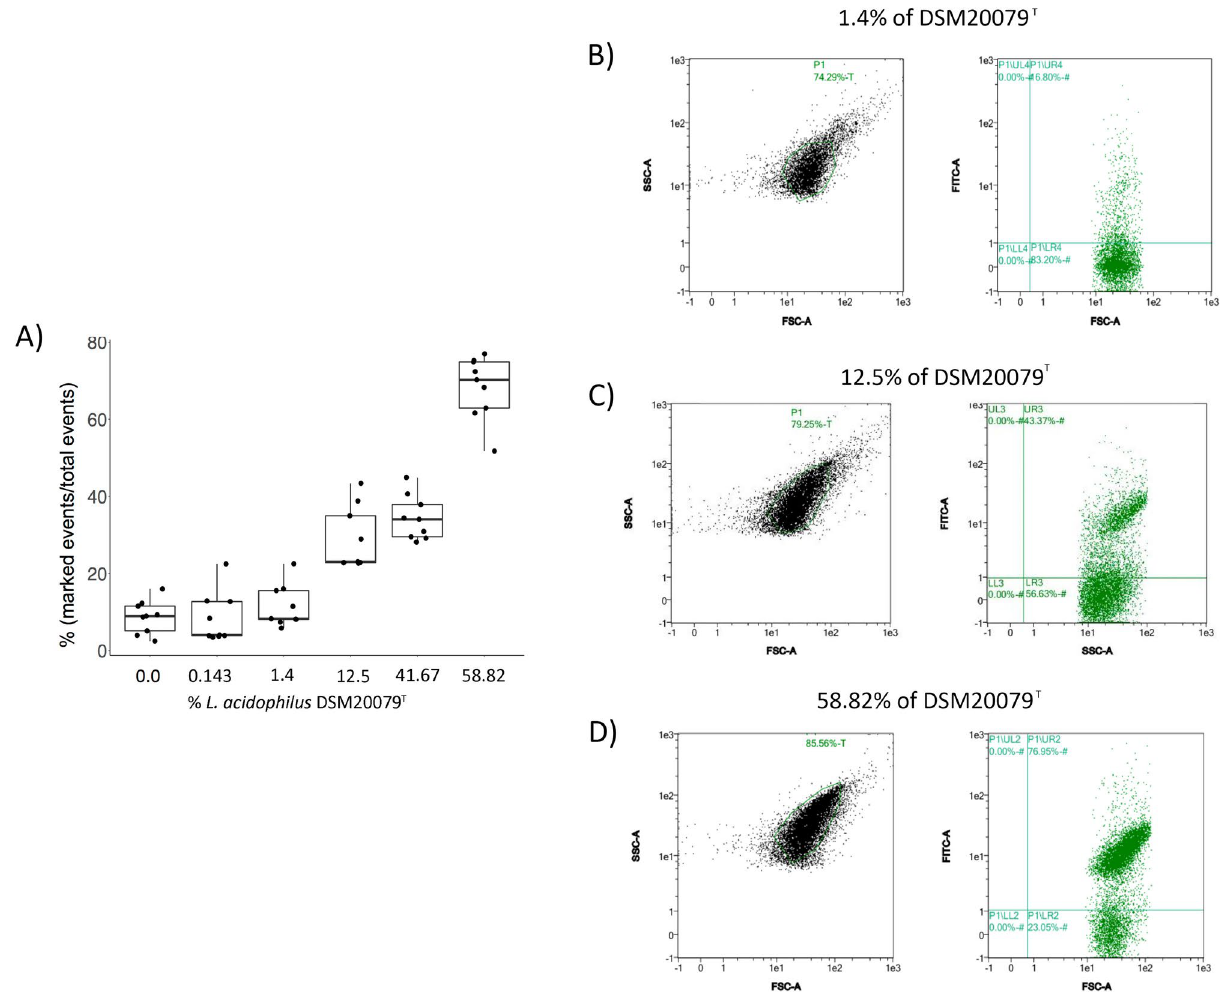
Figure 3. (A) Boxplot/jitter diagrams showing the percentage of L. acidophilus DSM20079 T cells labelled in a defined bacteria consortium representing a synthetic human gut microbiota. Data are represented as the mean ± SD of at least three independent experiments. As described in the M&M section, all bacteria were added in the same volumetric proportion with the exception of L. acidophilus , which was either absent or added at different percentages representing different proportions: 0.143%, 1.4%, 12.5%, 41.67% and 58.82%. (0.01:1, 0.1:1, 1:1, 5:1 or 10:1 ratios in term of volumes). The detection of DMS20079 T in a defined bacteria consortium was assessed in triplicate. (B–D) Dispersion diagrams of a representative FC experiment showing the detection of L. acidophilus DSM20079 T in a defined bacteria consortium when added at 1.4 (B) , 12.5 (C) , and 58.82 (D) percentages (volumetric proportion DSM20079 T : rest of bacteria, 0.1:1, 1:1, and 10:1, Enrichment and depletion of L. acidophilus from the fecal microbiotas (n = 5) also followed the same trend as the synthetic microbiota (Fig. 5; Supplementary Fig. 5). Fecal microbiotas were depleted from L. acidophilus